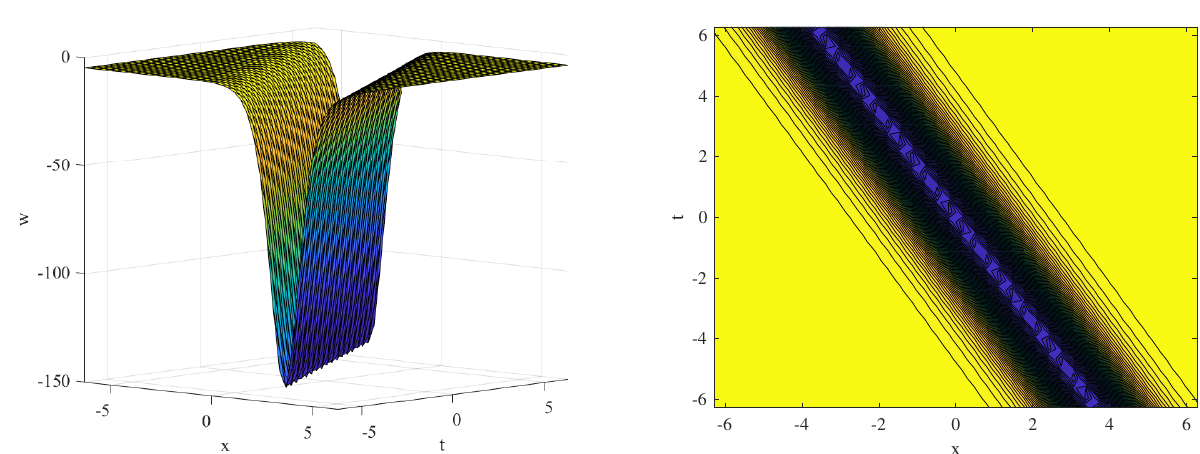
Figure 2. A traveling wave solution and a contour of solution (10) ( W 2 ( ξ )) under the parameters a 0 = a 1 = a 3 = 0, a 2 = 1, a 4 = − 20.